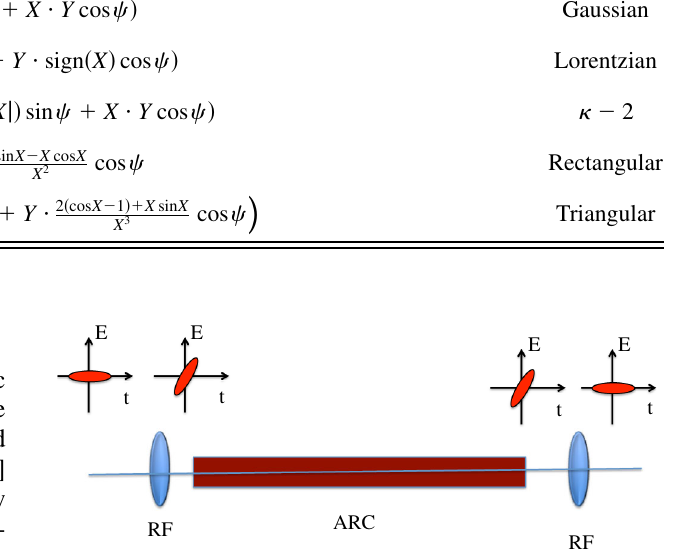
CHROMATICITY OF THE LATTICE AND BEAM . . TABLE I. Suppression of the beam’s response on a transverse kick by the chromaticity, C . In this table X ¼ (cid:5)(cid:6) f ð (cid:3) Þ